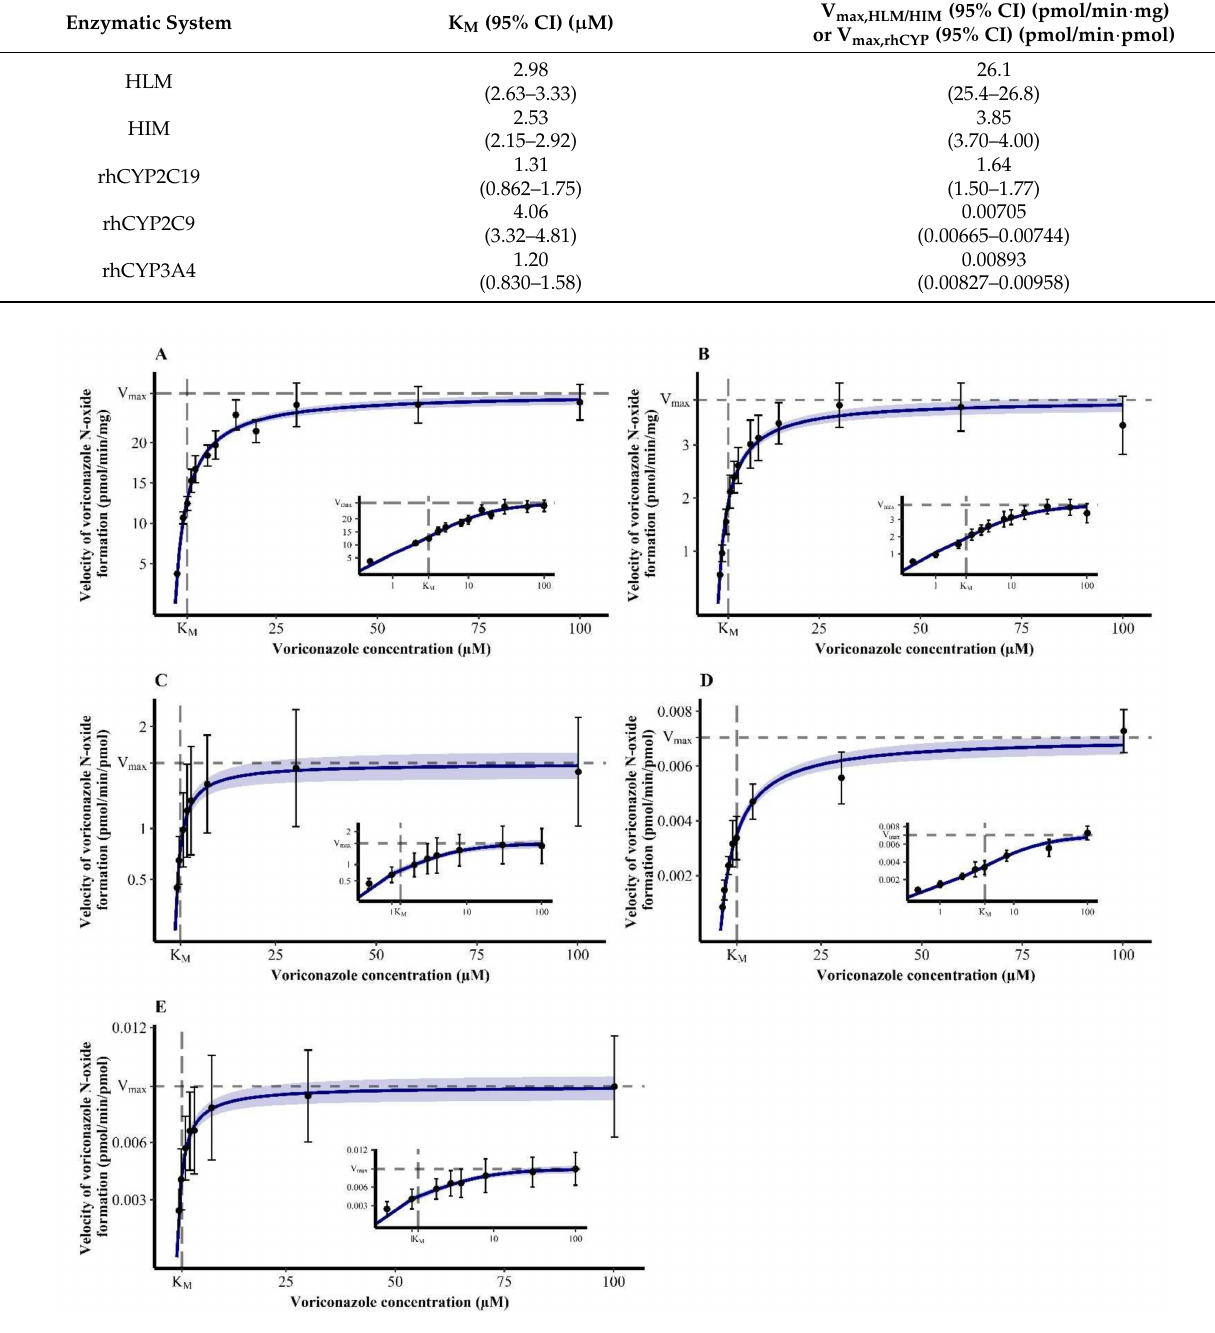
Table 1. Estimated Michaelis-Menten kinetic parameters, i.e., the Michaelis-Menten constant (K M ) and maximum reaction velocity (V max ), and their 95% confidence interval (CI) of the N -oxidation of voriconazole determined in human liver microsomes (HLM), human intestine microsomes (HIM) and recombinant human cytochrome P450 enzymes 2C19, 2C9 and 3A4 (rhCYP).